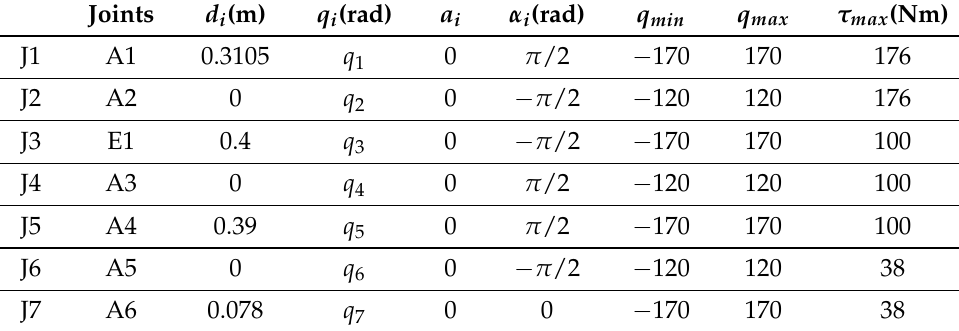
Figure 7. Exoscarne 3D simulated model with the KUKA LWR arm in Home configuration. Table 1. DH parameters of KUKA LWR 4+